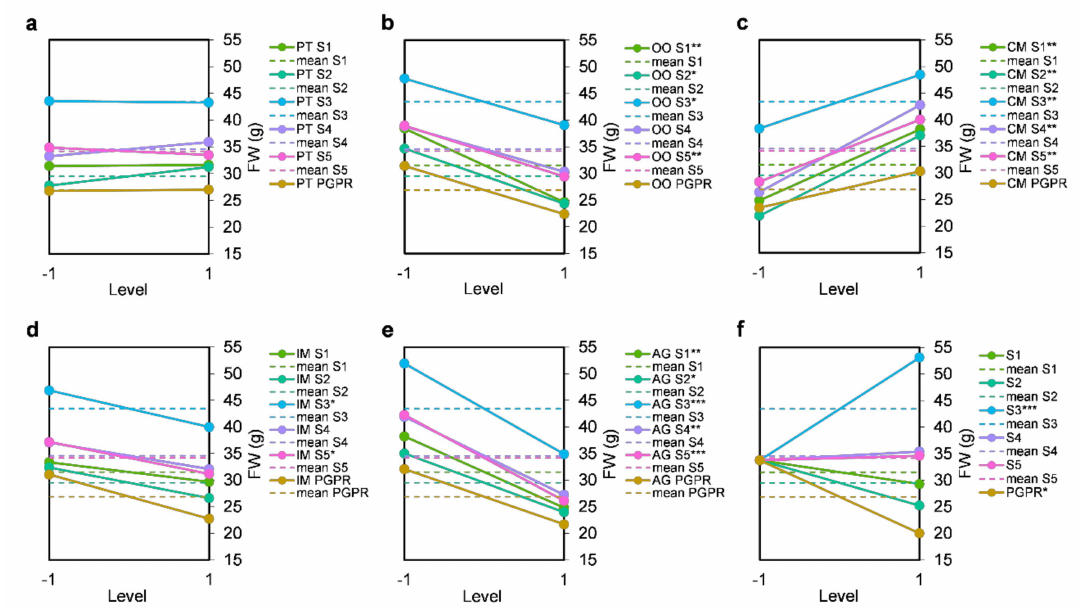
Figure 2. Main e ff ects of plant growing medium constituents on shoot fresh weight (FW; g) under di ff erent bacterial community inoculum treatments (S1–5 and positive control PGPR). ( a ) Peat (PT; − 1 = black peat and 1 = white peat); ( b ) Other organics (OO; − 1 = coir pith and 1 = wood fiber); ( c ) Composted materials (CM; − 1 = composted bark and 1 = green waste compost); ( d ) Inorganic materials (IM; − 1 = perlite and 1 = sand); ( e ) Arabic gum (AG; − 1 = 1 kg.m -3 and 1 = 5 kg.m − 3 ); ( f ) Bacterial inoculum (BCI; − 1 = C and 1 = S1–5 or PGPR). Dashed lines indicate mean levels of FW for each bacterial treatment. Asterisks indicate level of significance: P < 0.05 (*), P < 0.01 (**) and P < 0.001